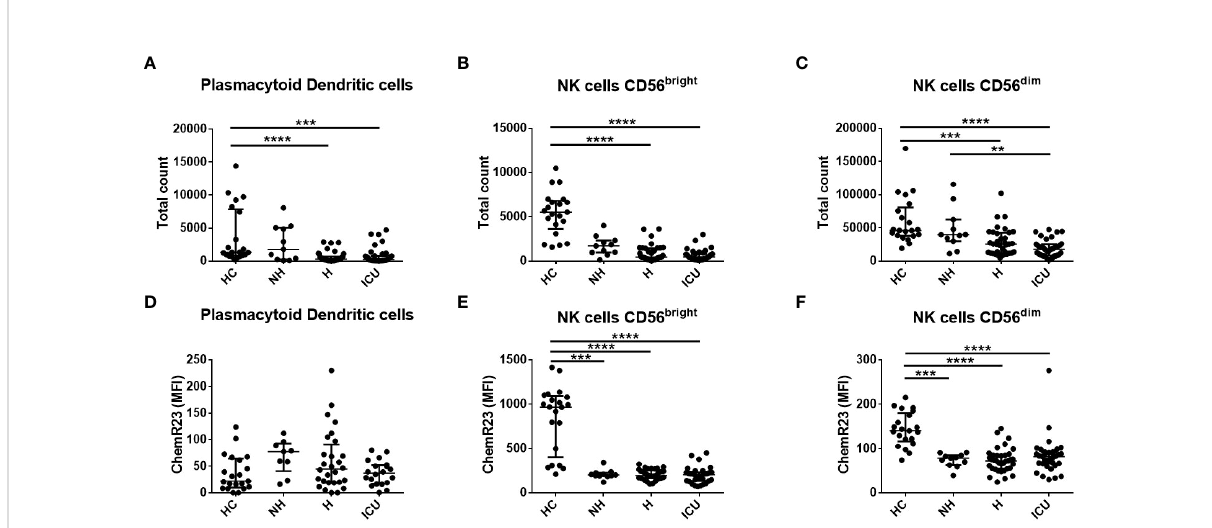
FIGURE 1 Flow cytometry analysis of the total number of plasmacytoid dendritic cells (pDC), natural killer (NK) cells CD56 bright and NK cells CD56 dim and their expression of ChemR23 in COVID-19 patients and healthy controls (HC) at day 1. (A – C) . Measurements by fl ow cytometry of total counts of pDCs, NK cells CD56 bright and CD56 dim . (D – F) . The expression of ChemR23 was evaluated by mean fl uorescence intensity (MFI). Data are presented as median with interquartile range and statistics analysis was performed using Kruskal-Wallis test followed by Dunn ’ s post-hoc test. Non-hospitalized (NH), n=11; hospitalized non-intensive care unit (H), n=36; hospitalized in intensive care unit (ICU), n=35 and healthy controls (HC), n=21. **: p<0.01; ***: p<0.001; ****: